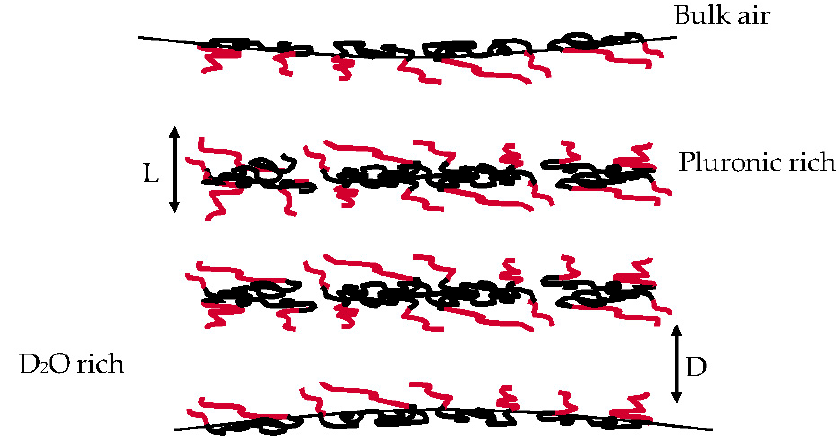
Scheme 1. Schematic presentation of the multilayer model of the adsorbed Pluronic layers at the air/water interface. L is the layer thickness and D defines the separation. Not to scale.